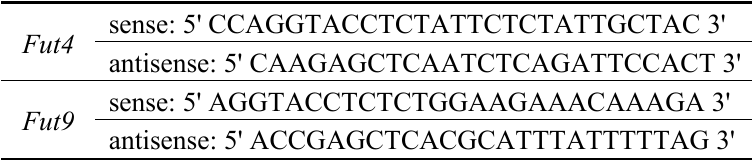
Table 3. Primers for sub-clones of Fut4 and Fut9 AR-binding